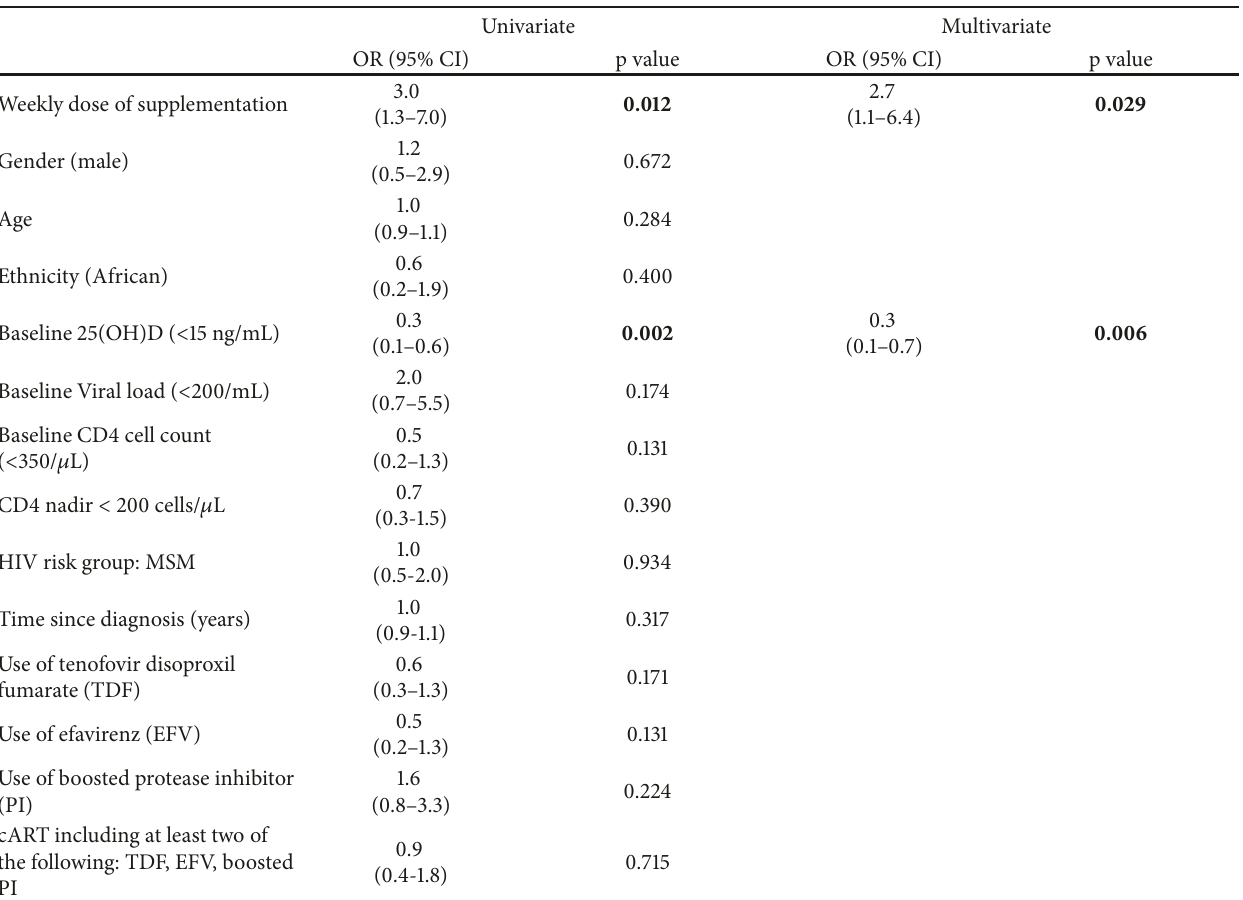
Table 2: Results of the univariate and multivariate regression analysis on the association between a 25(OH)D serum level of ≥ 30 ng/mL and supplementation after 12